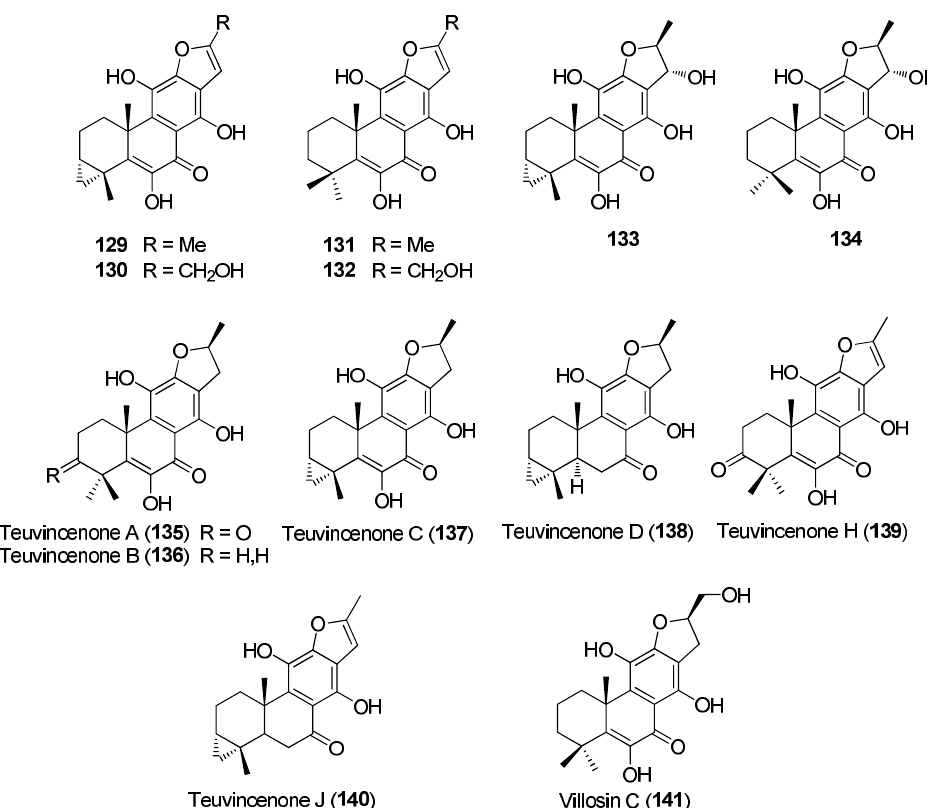
Figure 9. Representative abeo -abietane diterpenoids isolated from Teucrium polium.